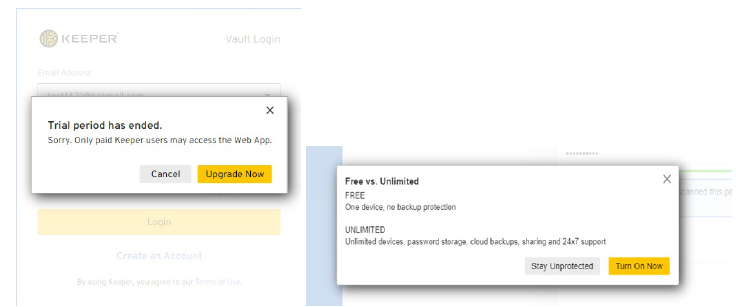
Figure A25. Webpage cannot be used on another device for free.